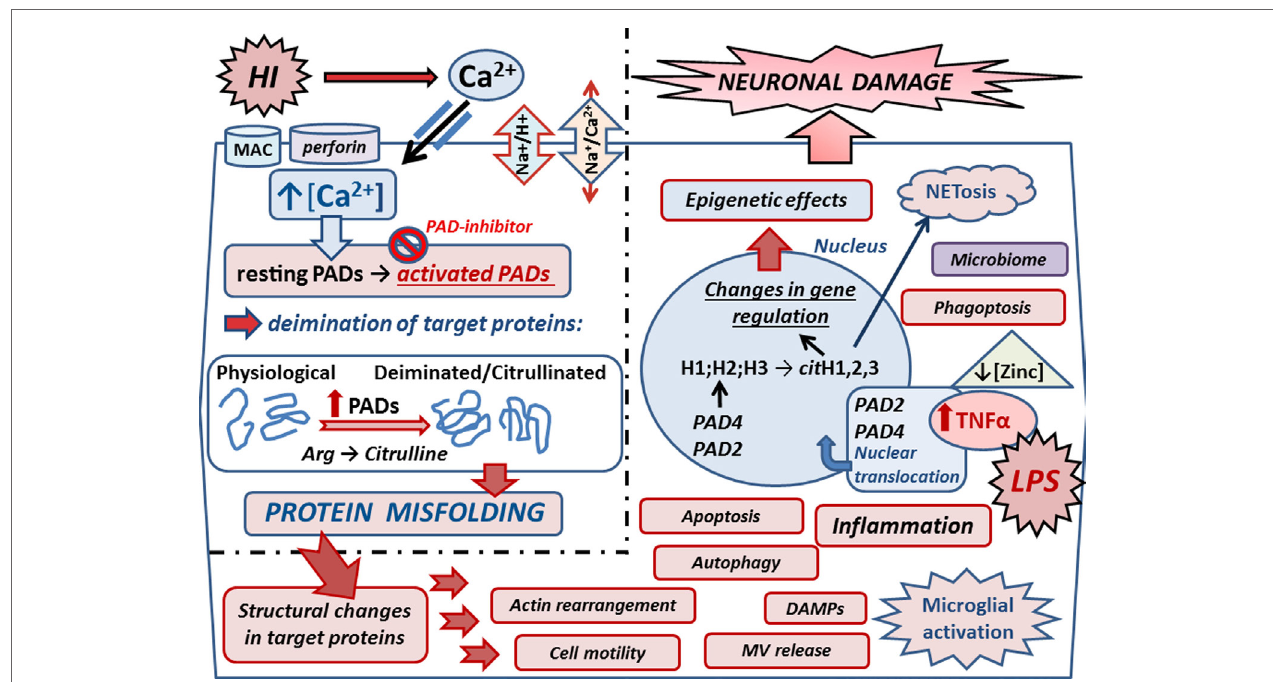
FiGURe 2 | Mechanisms of peptidylarginine deiminases (PADs) in Hi and synergistic infection . Upon HIE, Ca 2 + entry is facilitated via reversal of the Na + / Ca 2 + exchanger due to over activation of the Na + /H + exchanger (NHE). Ca 2 + entry can also be facilitated due to membranolytic pathways including the complement membrane attack complex (MAC) and perforin. Increased cytosolic Ca 2 + triggers the neurotoxic cascade, which includes activation of the Ca 2 + -dependent PAD enzymes. Upon increased intracellular Ca 2 + , resting PADs are activated and catalyze the conversion of arginines into citrullines in target proteins. Protein deimination causes conformational changes and protein misfolding, affecting protein function and protein–protein interaction. Actin and cytoskeletal rearrangement is affected causing changes in cell motility, microvesicular (MV) release, autophagy, and phagoptosis. Deiminated neo-epitopes result in damage-associated molecular patterns (DAMPs) and contribute to inflammatory processes, such as microglial activation and downstream cascades. Inflammation causes upregulation of TNF α , which also is induced upon infection as mimicked by LPS stimulation in the HI/LPS synergy model. Raised TNF α levels cause translocation of PADs into the nucleus where they deiminate histones and affect gene regulation and epigenetics. Histone deimination also leads to extracellular trap formation (NETosis), which forms part of the microbial defense but can also cause the generation of neo-epitopes, leading to auto-inflammatory responses. Zinc is hypothesized to be a regulator of PADs, and as zinc levels are reduced in sites of infection, this regulatory role is lost, leading to increased protein deimination during infection. Individual variations of the neonatal microbiome may add to the complexity of the interplay of microbial defenses via NETosis and impact microglial activation and other mechanisms that remain to be elucidated. PAD inhibition with the pan-PAD inhibitior Cl-amidine has been successful in neuroprotection in the Rice–Vannucci mouse model of HI and HI/LPS synergy model, significantly reducing microglial activation, neuronal loss, and cell death. Refined inhibitors of PAD activation thus pose promising combinatory treatment options in synergy with current hypothermia